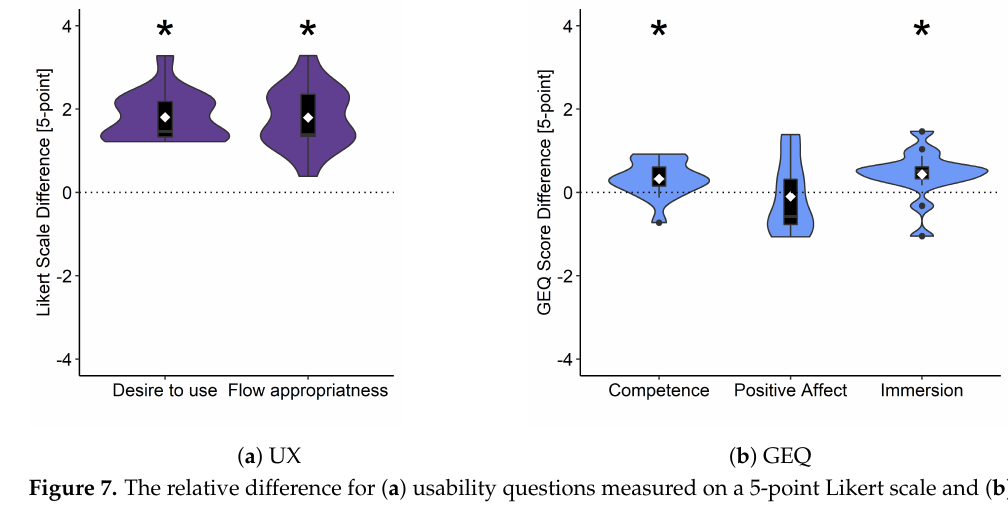
Figure 7. The relative difference for ( a ) usability questions measured on a 5-point Likert scale and ( b ) GEQ subscales (Competence, Positive Affection, and Immersion). * indicates that measurements are significantly different from the no-adaptation baseline. Outliers were defined as data points with a value greater than 2 SDs on the log-scale from its participant-mean. Outliers are represented as bold